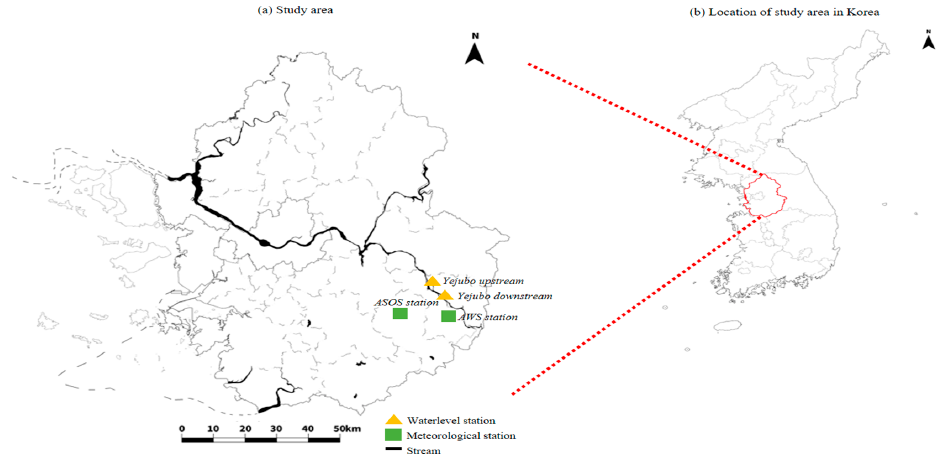
Figure 6. Location of water level and meteorological data stations in the test bed area. ( a ) Description of Yeojubo; ( b ) description of Gyeongi Province.